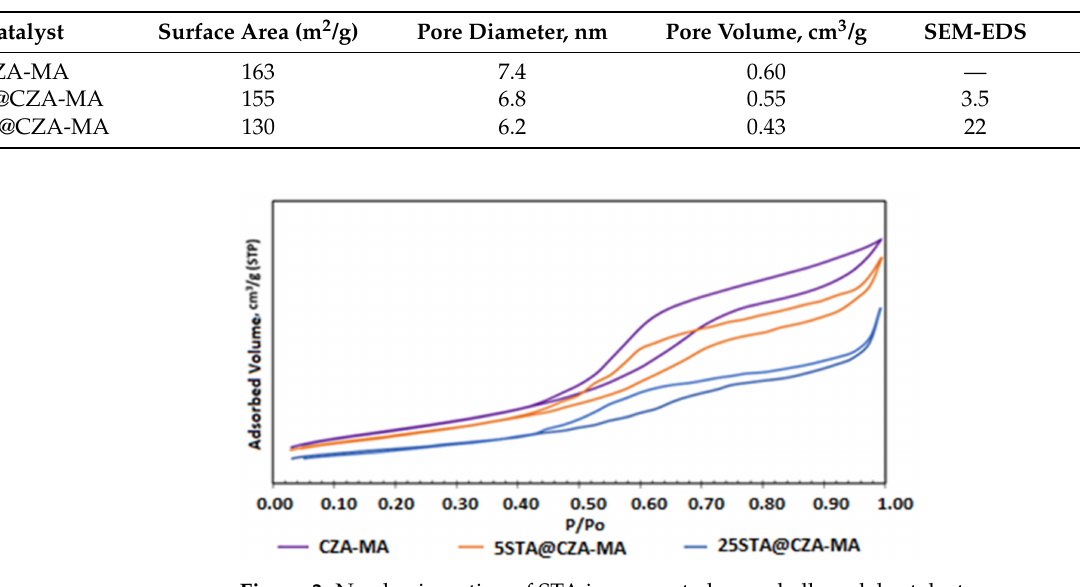
Figure 3. N 2 physisorption of STA incorporated core-shell model